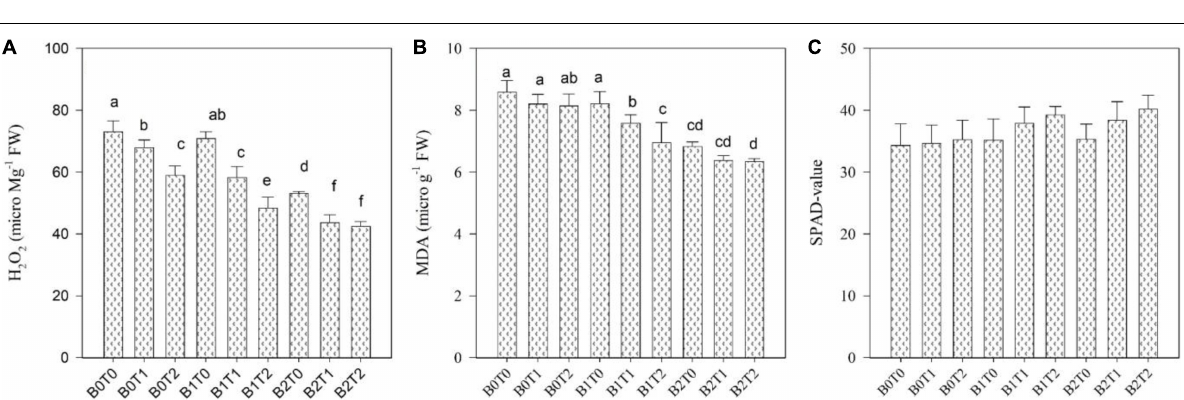
with control. Likewise, exogenous application of T 2 significantly minimized the MDA, H 2 O 2 , and EL values by 5, 9, and 8%, respectively, compared with control. Correspondingly, combined